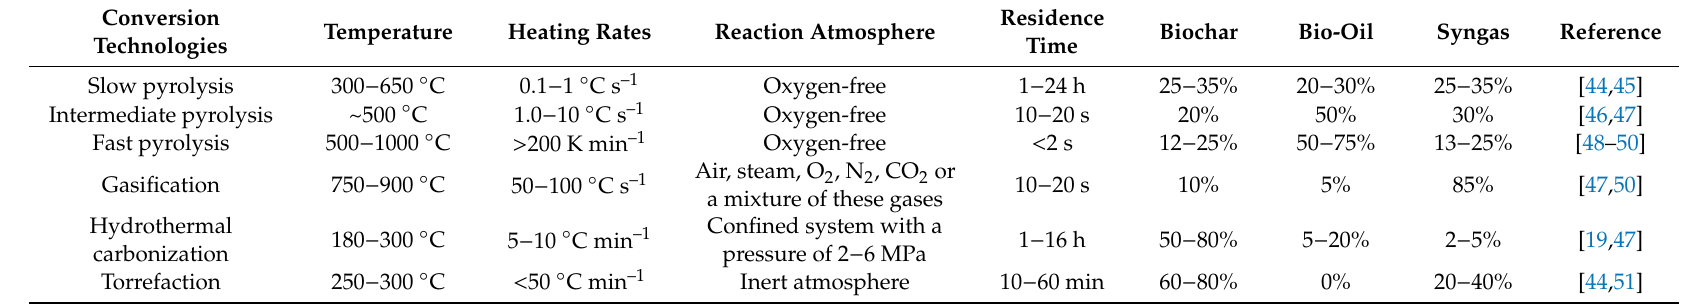
Table 1. The reaction conditions and product distribution of various thermochemical conversion